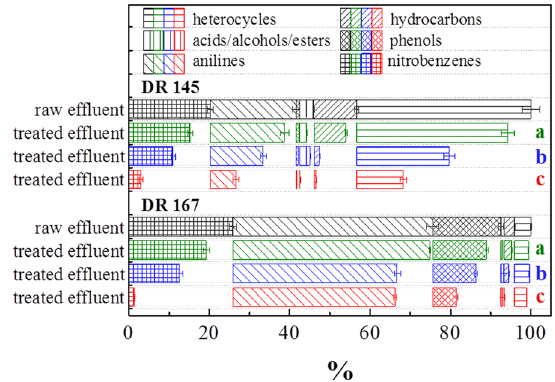
Figure 7. Organic composition of dispersed dye-production wastewater treated by ( a ) PAC coagulation, ( b ) the one-step process of organobentonite and ( c ) the one-step process with PAC. Bentonite dose: 0.5 g L − 1 , CTMAB